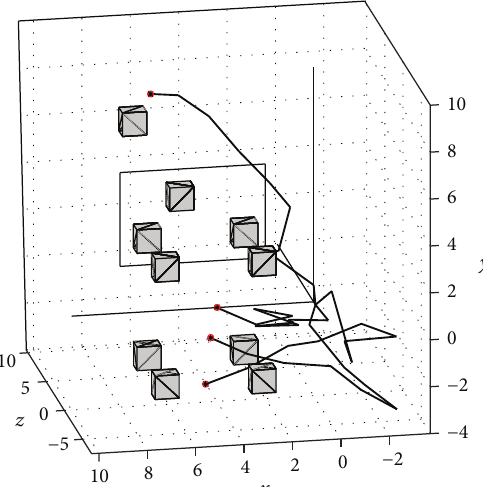
Figure 7: A 9-link manipulator design with the first 6 links in PUMA configuration.